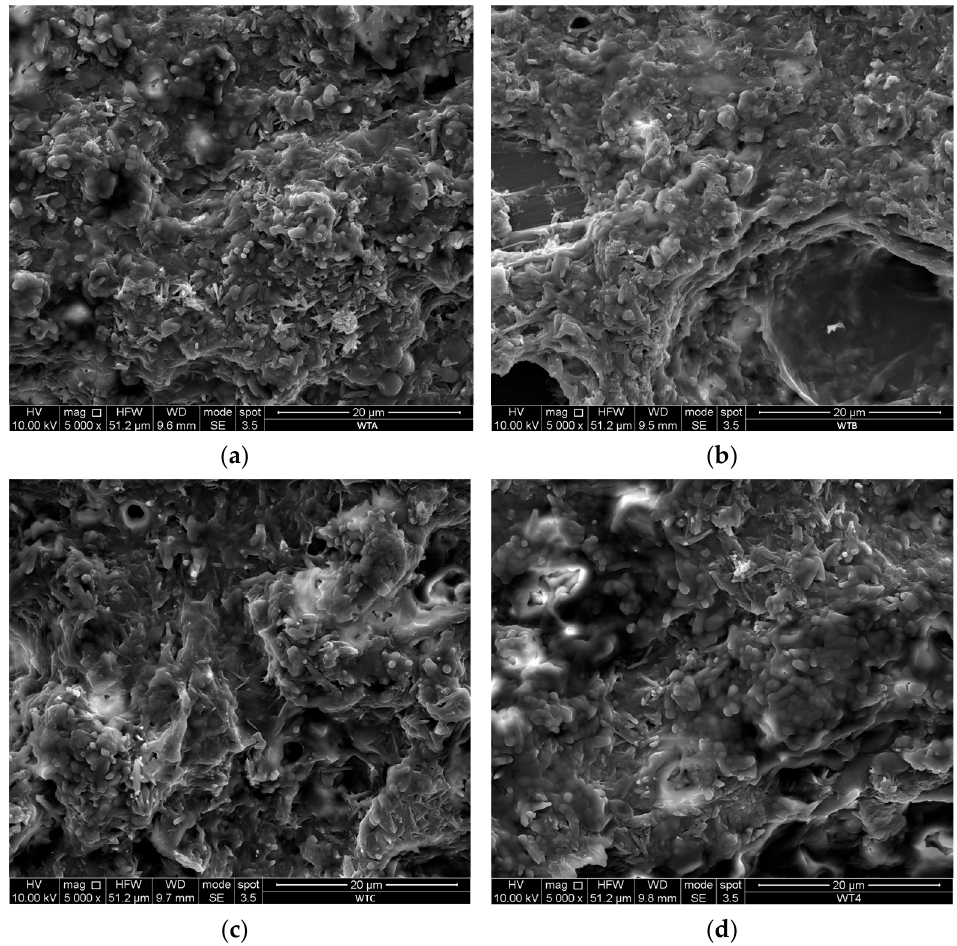
Figure 2. Scanning electron microscopy (SEM) observations of wooden splinters from wooden ta- bles used during PDO Provola dei Nebrodi cheese production. Pictures of the wooden splinters from dairy factories A–D ( a – d ).